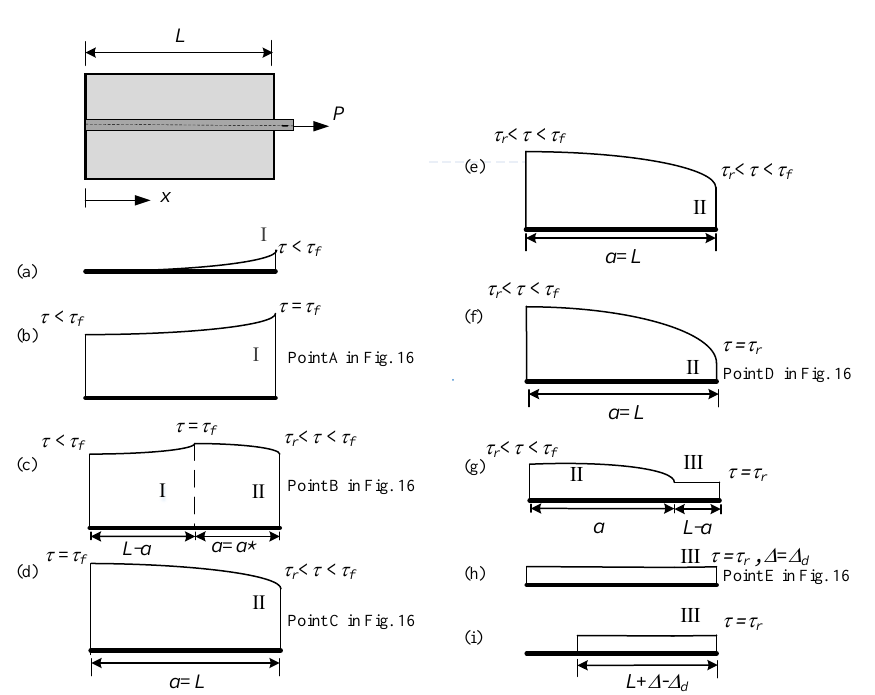
Figure 15. Evolution of interfacial stress distribution along a steel fibre: ( a , b ) Elastic stage; ( c , d ) elastic–softening stage; ( e , f ) softening stage; ( g , h ) softening–debonding stage; ( i ) frictional stage; I, II and III represent elastic, softening, and debonding stress state, respectively.